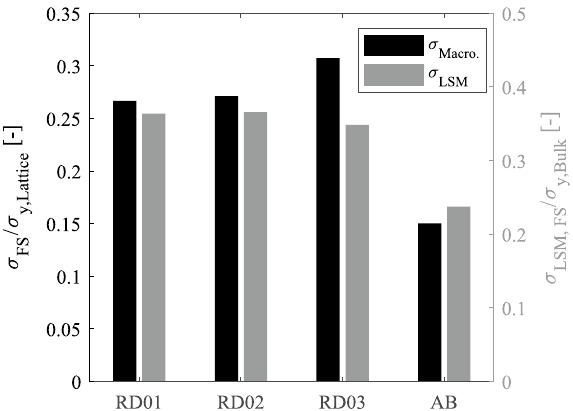
Figure 17. Normalization of fatigue strength with yield strength and local stress